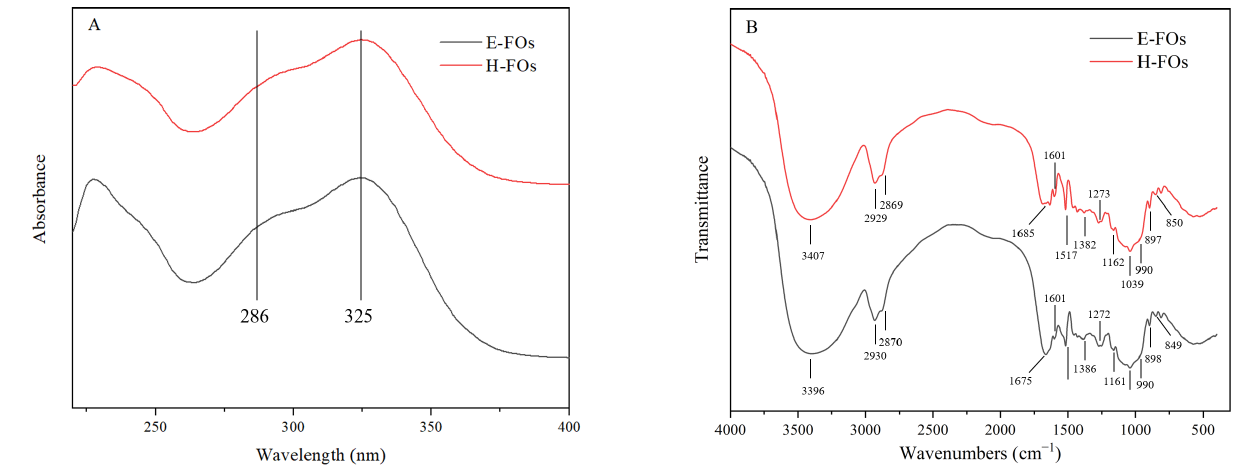
Figure 4. The UV ( A ) and FT-IR spectra ( B ) of H-FOs and E-FOs. H-FOs are the feruloyl oligosac- charides prepared by traditional hydrolysis and xylanase hydrolysis, and E-FOs are the feruloyl oligosaccharides prepared by enzymatic extrusion and xylanase hydrolysis.